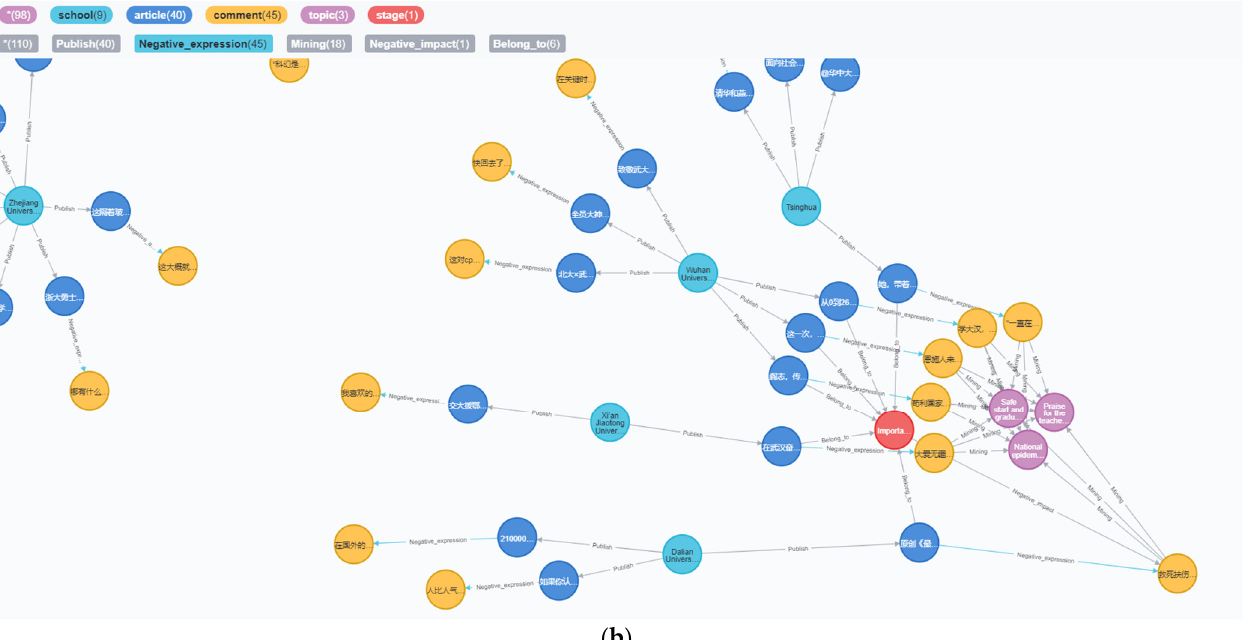
Figure 14. ( a ) Search results for negative comments on university official accounts articles containing “dead”. ( b ) Deeper search results based on figure ( a ).